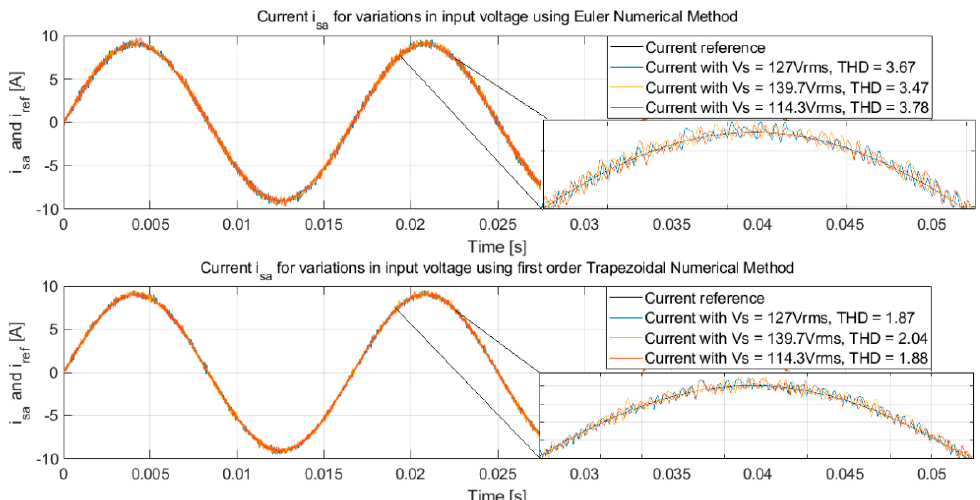
Figure 16. Current i sa for variations in the input voltage using Euler and first ‐ order trapezoidal ap ‐ proximations.